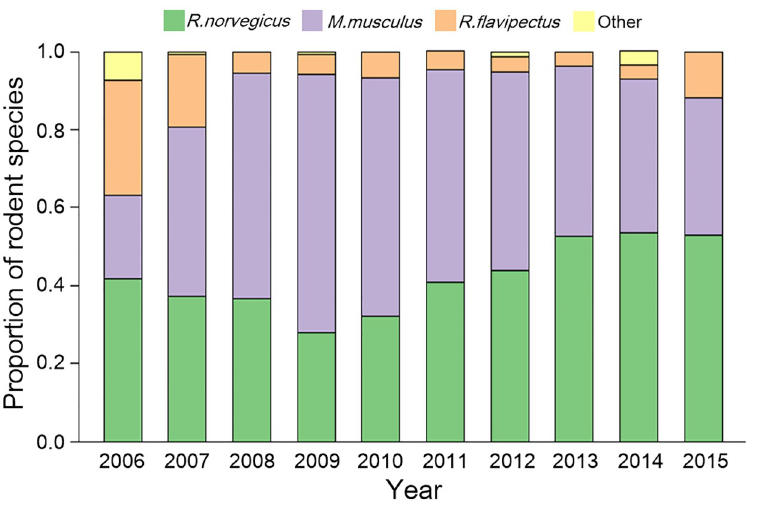
Fig 4. Proportion of each rodent species trapped in Chenzhou City, 2006–2015. Each column indicates the proportion of different rodent species (green: R . norvegicus ; purple: M . musculus ; orange: R . flavipectus ; yellow: other species) in a